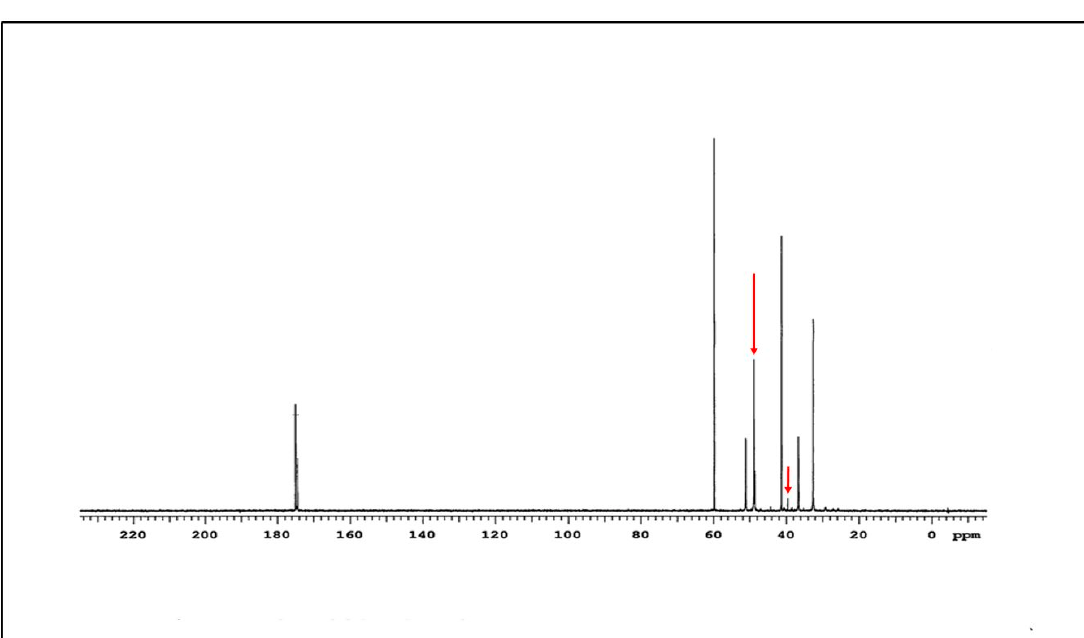
Figure 2. Synthesis of G4-90/10.